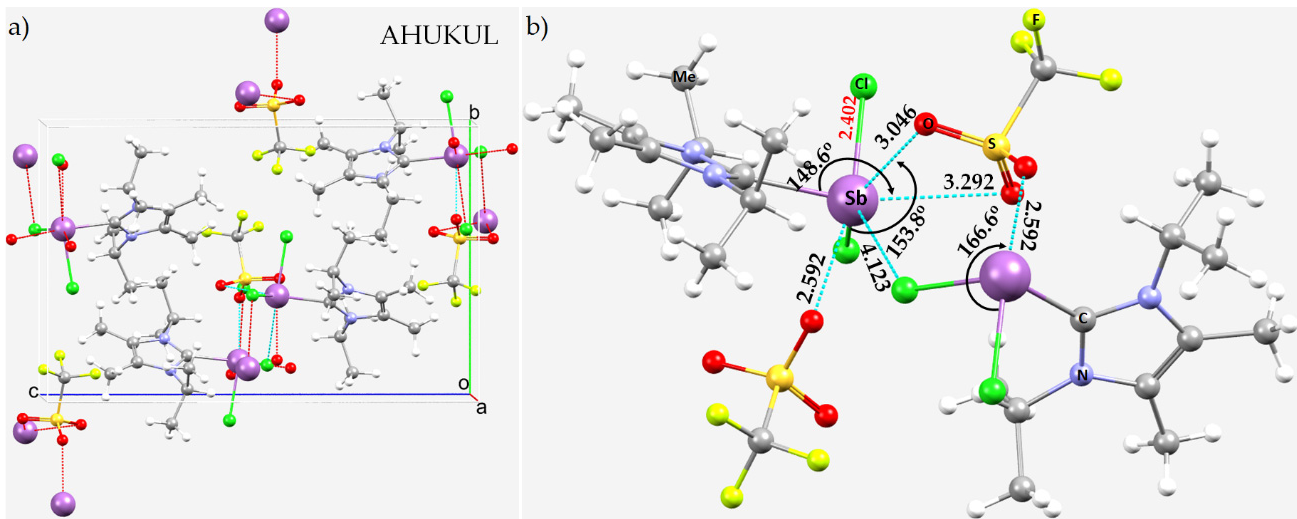
Figure 17. ( a ) The unit-cell crystal structure of [SbCl 2 imR 2 R’ 2 ][OTf]. ( b ) The nature of coordination environment around the Sb center is highlighted. The hanging contacts represented by dotted lines in red are Sb···O pnictogen bonding interactions. The CSD reference code is shown, and selected bond lengths and bond angles are in Å and degrees, respectively. Atoms are shown as small spheres and bonds as lines in atom color, whereas the intermolecular interactions are represented by dotted lines in cyan/red.